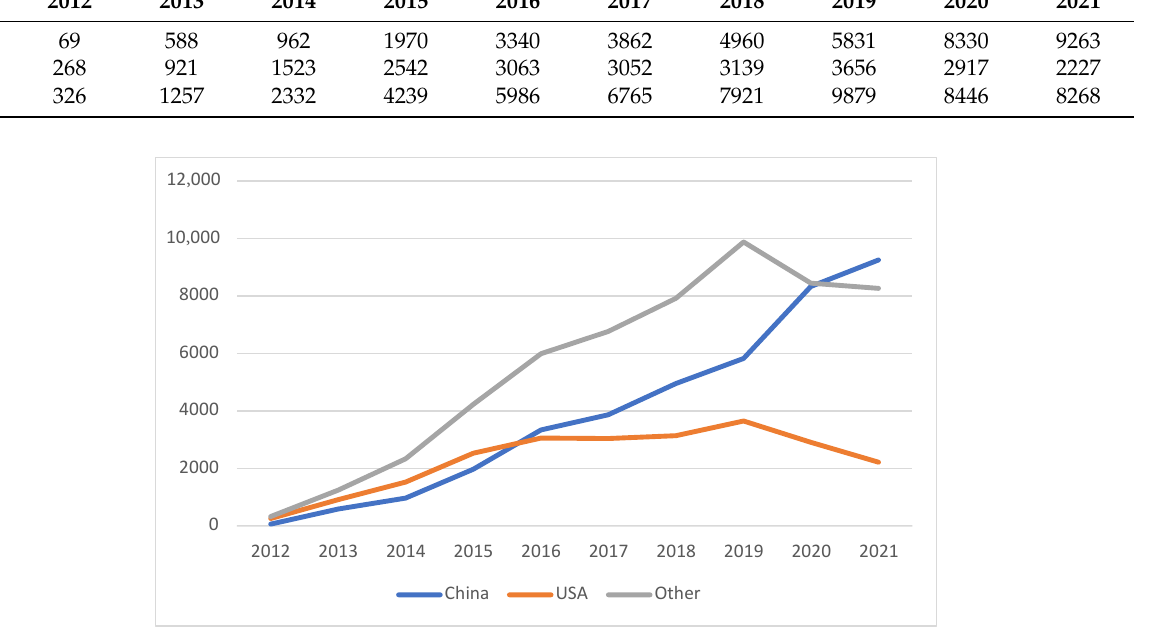
Figure 6. The number of research publications in Big Data per year for different geographic regions.